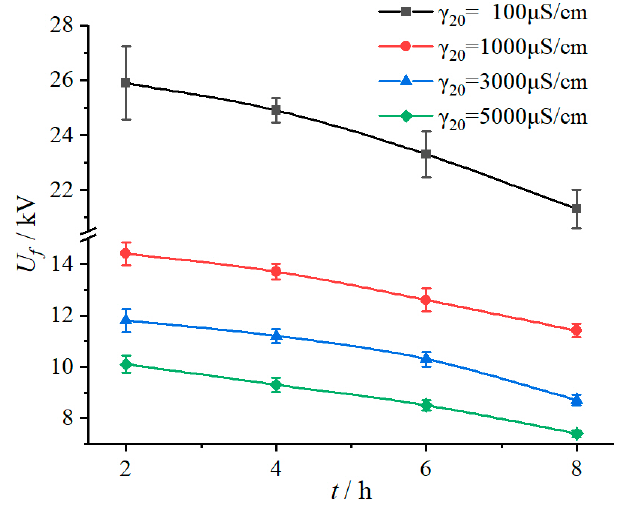
Figure 4. Relationship between U f and t (DC 3.2 kV).